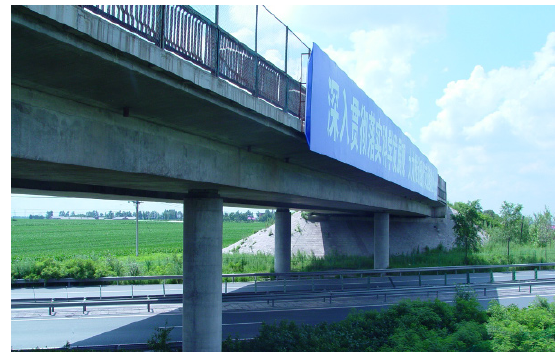
Figure 1. Hashuang bridge structure